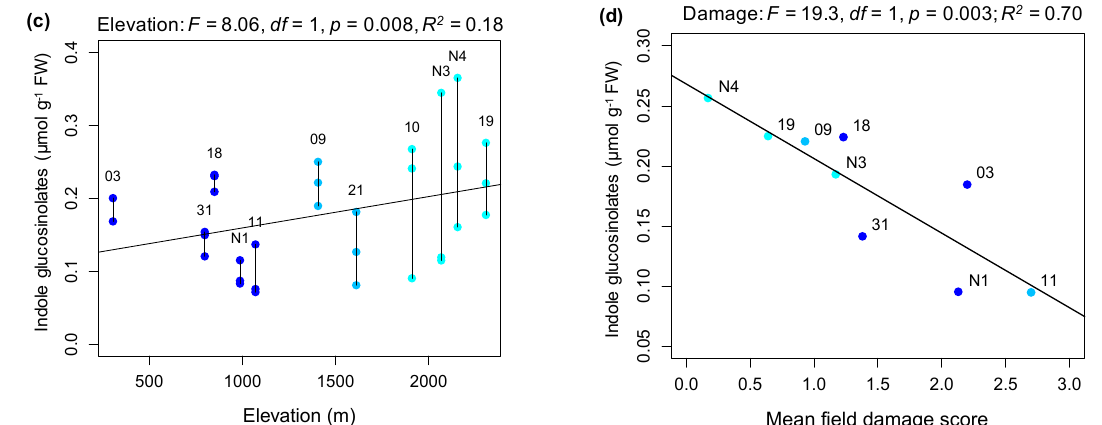
Figure 1. Variation in damage to plants in the field and associations with constitutive leaf chemical defenses. ( a ) Distribution of all 13 study populations of Arabidopsis halleri with different colors indicating the broad elevation class of a population. ( b ) Regression of average damage score (based on percentage of leaves damaged) per population with point size weighted by number of patches surveyed, and a line joining fitted value estimates from the corresponding linear model. ( c ) Regression of total indole glucosinolates (in micromoles per gram of fresh tissue, µmol g − 1 FW) against elevation (with samples from the same population joined by black vertical lines). ( d ) Regression of mean total indole glucosinolates per population against mean field damage score. The significance of the effect of elevation and adjusted R-squared is given for ( b,c , d ). Points in regression plots are labelled by population identifiers.